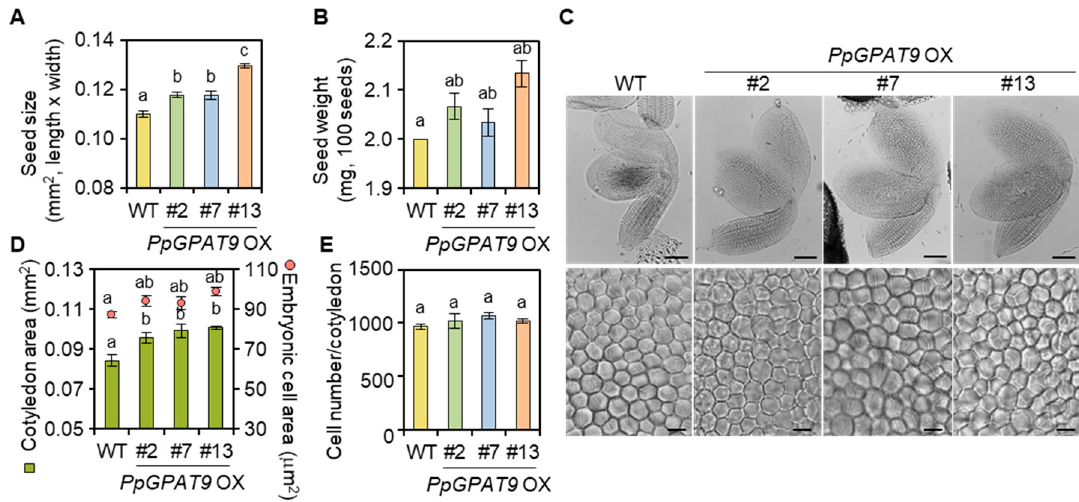
Figure 5. Microscopic analysis of seeds of the WT and transgenic Arabidopsis ectopically expressing PpGPAT9 (#2, #7, and #13). ( A ) Length and width of seeds of the WT and transgenic lines (#2, #7, and #13). The data were statistically examined using ANOVA with Tukey’s test at 95% confidence interval. ( B ) Seed weight per 100 mature dried seeds of the WT and transgenic lines (#2, #7, and #13). The data were statistically examined using ANOVA with Tukey’s test at 95% confidence interval. ( C ) Images of mature embryos (upper image) and embryonic cells in the central region of the cotyledon (bottom image) obtained from dried seeds of the WT and transgenic lines (#2, #7, and #13). Bars = 0.1 mm (upper image). Bars = 0.01 mm (bottom image). ( D ) Cotyledon size and epidermal cell size of embryonic cells of the WT and transgenic lines (#2, #7, and #13). Each value is the mean ± SE of three independent measurements. The data were statistically analyzed using ANOVA with Tukey’s test at 95% confidence interval. ( E ) Epidermal cell number of adaxial cotyledons in the WT and transgenic lines (#2, #7, and #13). Each value is the mean ± SE of three independent measurements. The data were statistically analyzed using ANOVA with Tukey’s test at 95% confidence